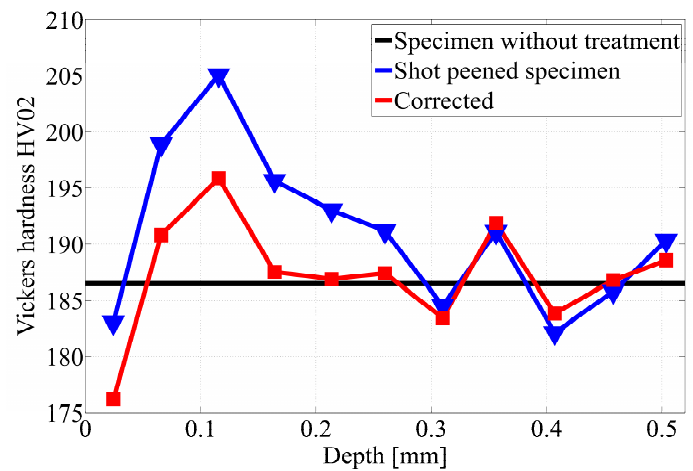
Figure 6. Hardness in a specimen treated with shot peening.